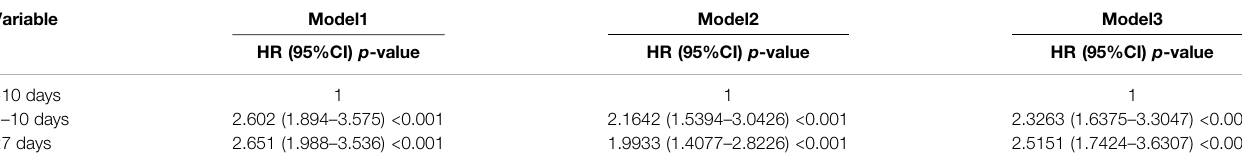
Model 1: univariate. Model2:adjustforCKD,norepinephrine,vasopressin,cefazolin,tracheostomy,GC,PEG,POUF,TT,SCR,BMI,urineoutput,DBP,MBP,antibioticuseduration,temperature,admission age, hemoglobin, RBC, RDW, ALT, platelet count, bicarbonate, and basophils. Model 3: adjusted forAntibiotics day, CKD, norepinephrine, Vasopressin, CefazoLIN, tracheostomy, GC, PEG, POUF, TT, APSIII, charlson comorbidity index, SCR, GCS, SOFA, LODS, MELD, SAPSII, BMI, urineoutput, DBP, MBP, temperature, Admission age, Hemoglobin, RBC, RDW, ALT, platelet count, Bicarbonate and Basophils.